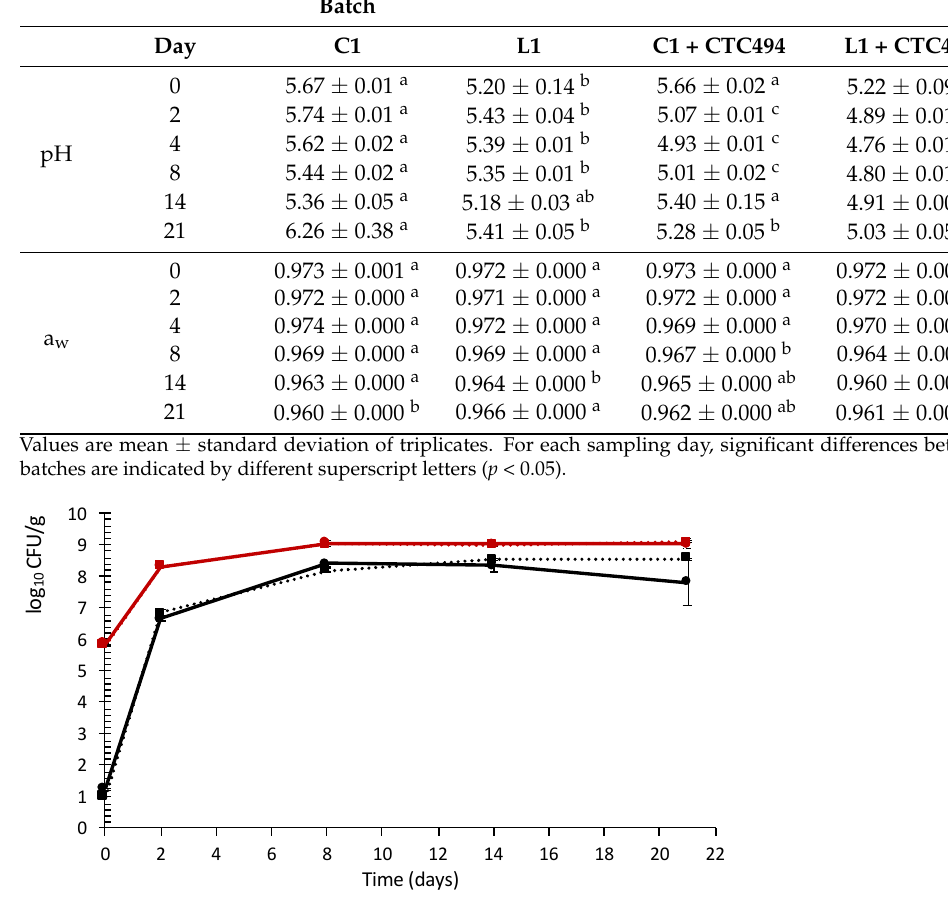
Table 2. Values of pH and a w (mean ± standard deviation) during the fermentation and ripening of pork sausages. Batches included sausages formulated without (C1) or with (L1) cava lees, spontaneously fermented or with the addition of a starter culture ( L. sakei CTC494).